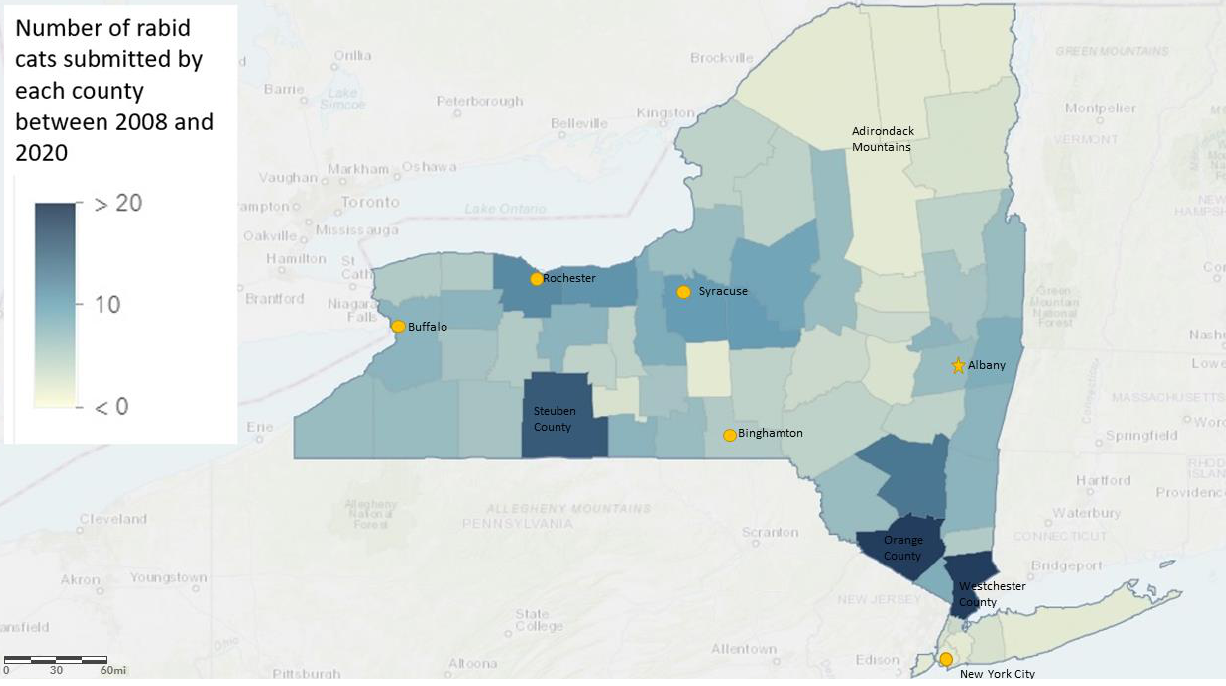
Figure 4. Number of rabies-positive cats based on New York county data (excluding New York City and Long Island).